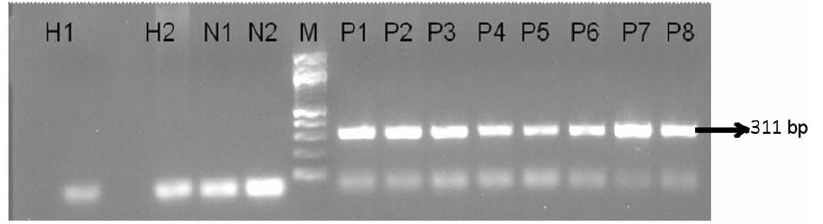
Figure 3. PCR results in clinical samples. Lanes H1and H2: Non-endemic healthy controls, Lane N1 and N2: negative controls, Lanes P1 to P8: VL patients, M=100 bp